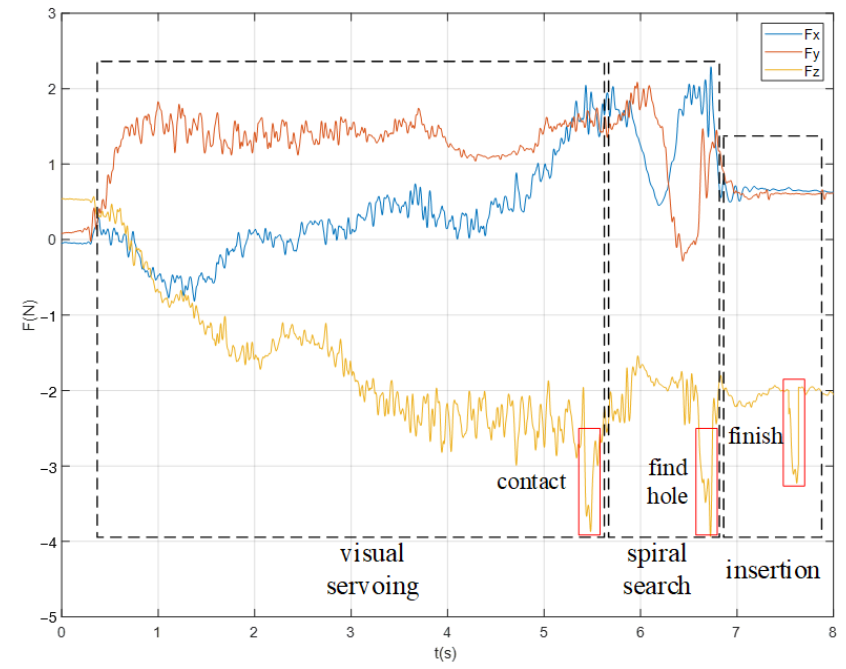
Figure 22. Force profile in the peg-in-hole assembly process.